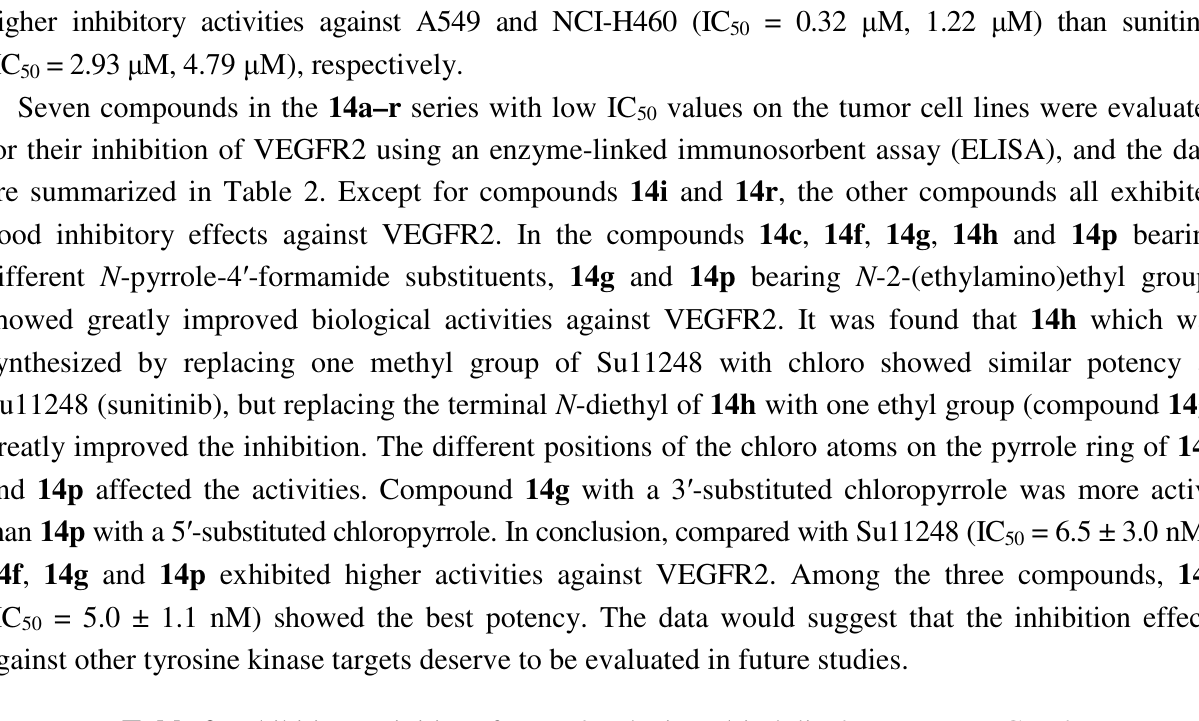
Table 2. Inhibition activities of some 3-substituted-indolin-2-ones on